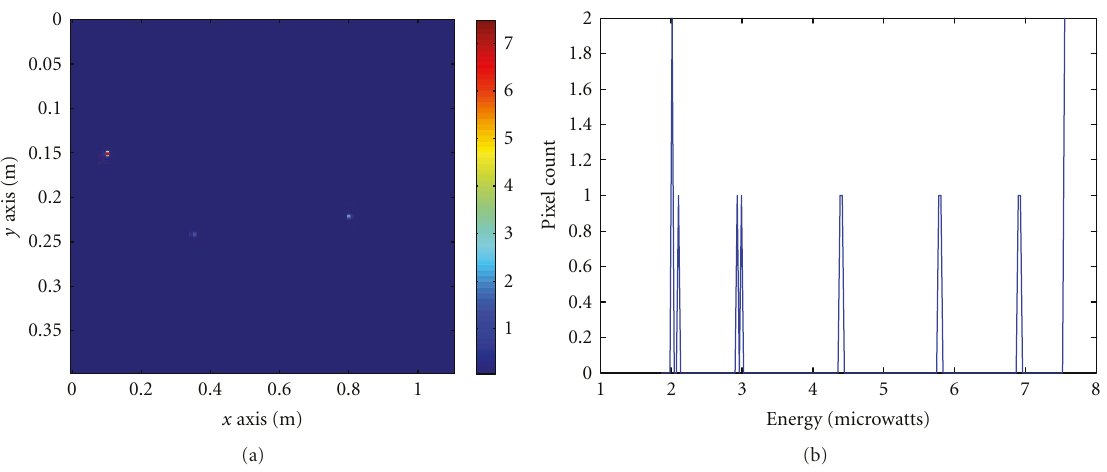
Figure 6: (a) Reconstructed data set using v = v sim . (b) Image